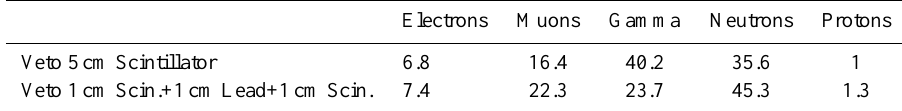
Table 3. Percent of different secondary particles detected by 25-cm thick scintillator in 2 versions of the SEVAN (Aragats station at 3200m above sea level).